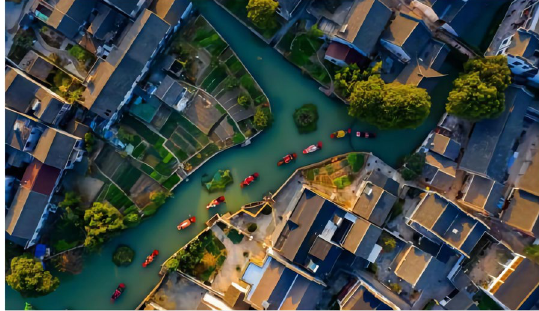
Fig. 3 Aerial view of Digang Food Street (Source: provided by the Digang Fish Restaurant)